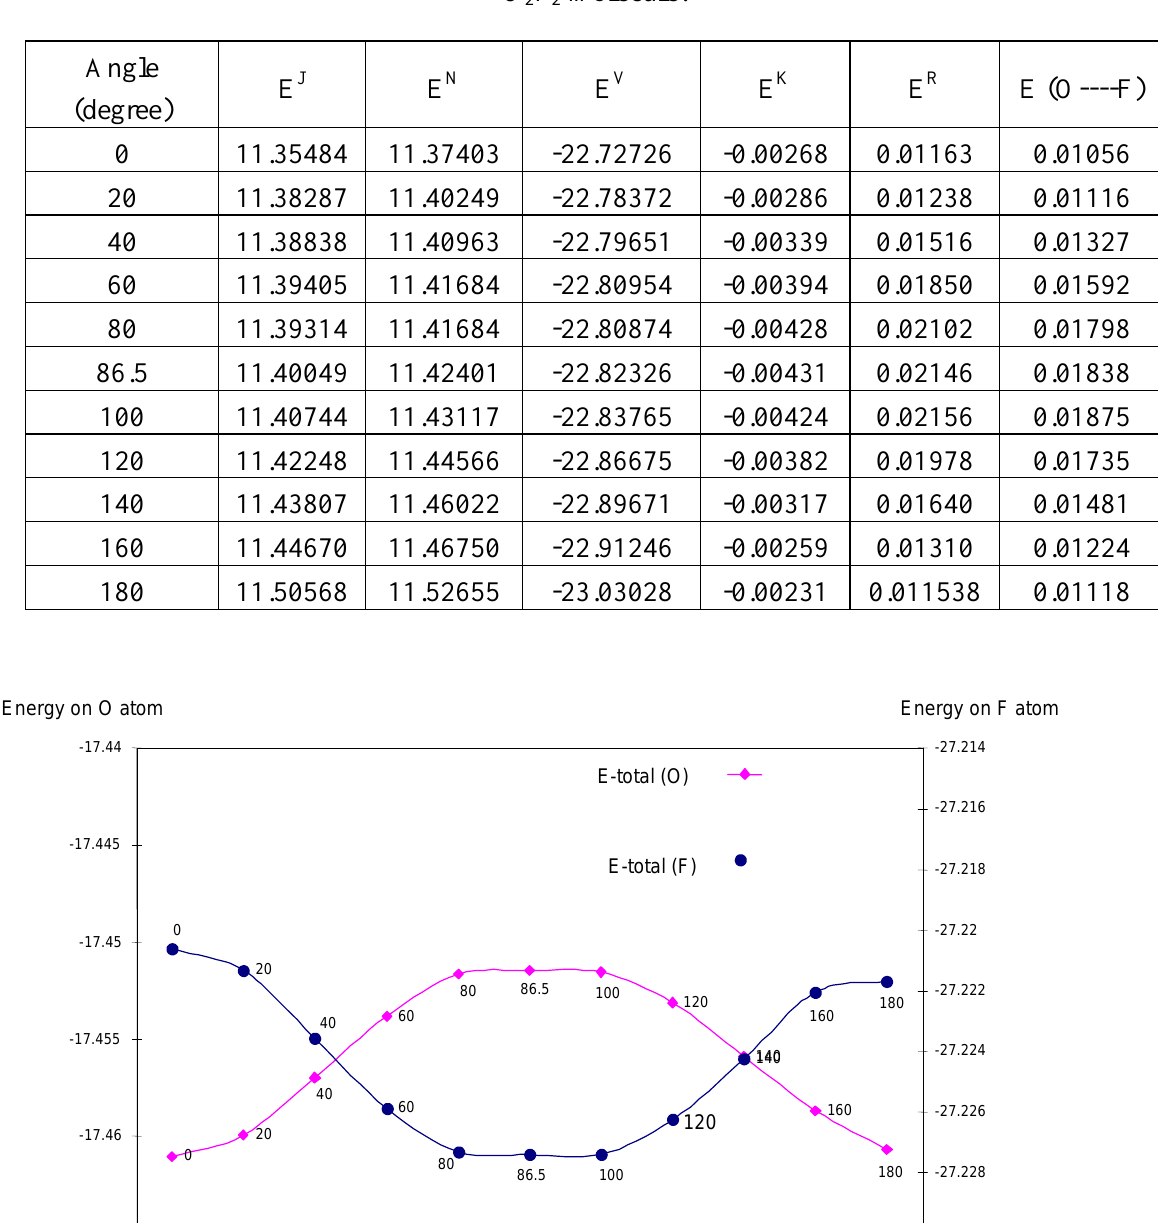
Table 11. The two-center ‘O----F’ nonbonding interaction and their physical components (a.u) in